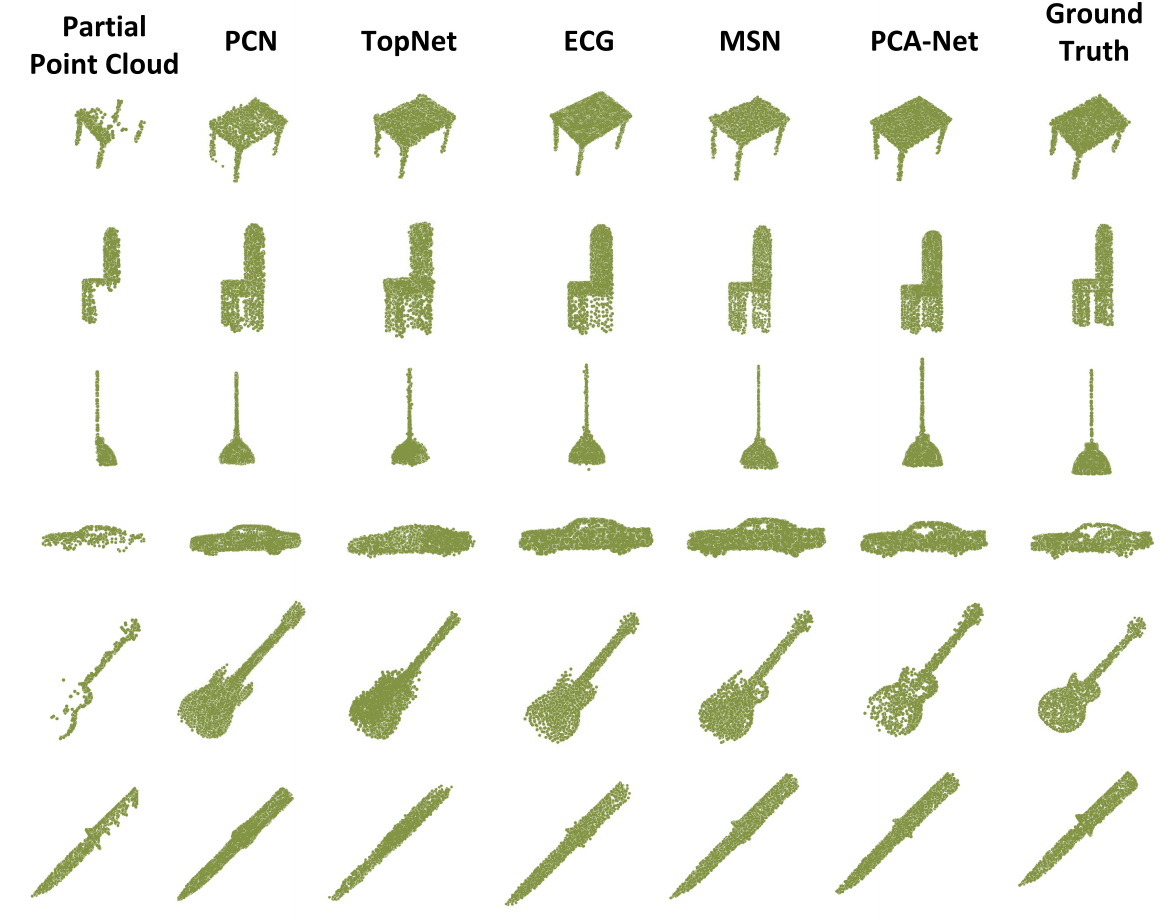
Figure 6. Qualitative completion results (2048 points) for the ShapeNet-Part dataset using different methods. PCA-Net generates better complete point clouds than other